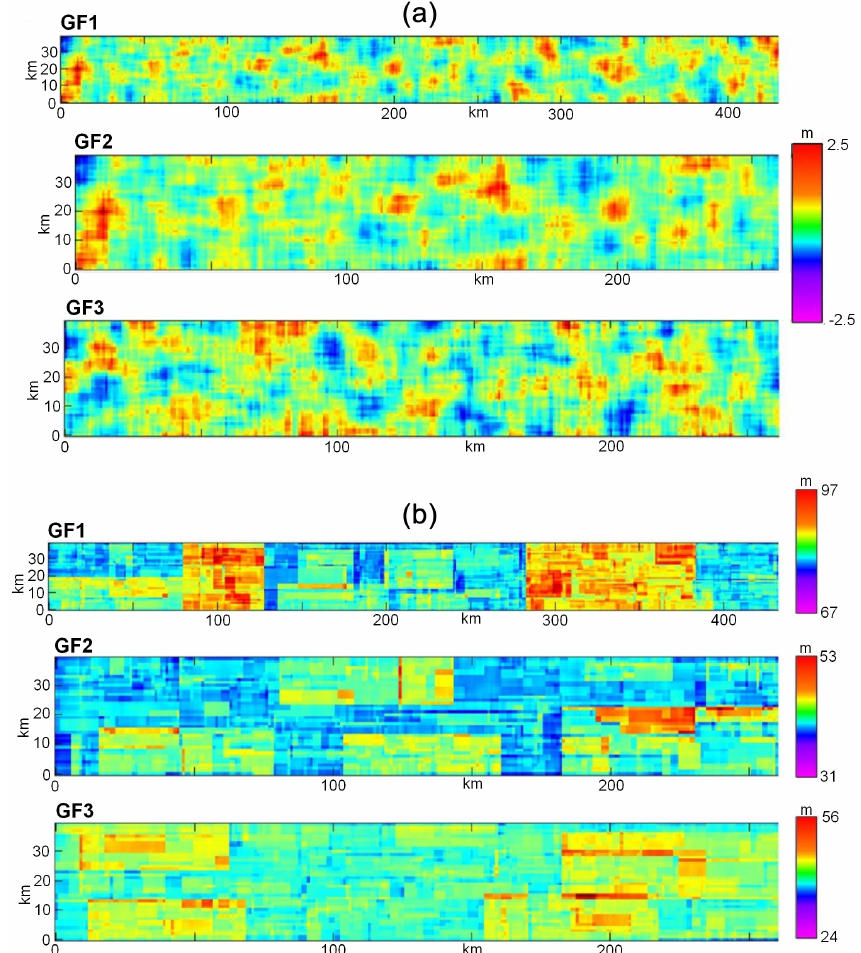
Figure 5. (a) Initial slip on the Gloria Fault active sections (GF1, GF2, and GF3) after a smoothed random slip generation, with zero mean. (b) Final slip on the Gloria Fault sections after 20000 years of a synthetic catalogue. Minimum, maximum, and nominal cumulated slips are (in m) GF1 (67 to 97, 80), GF2 (30 to 53, 40), and Gf3 (24 to 55,